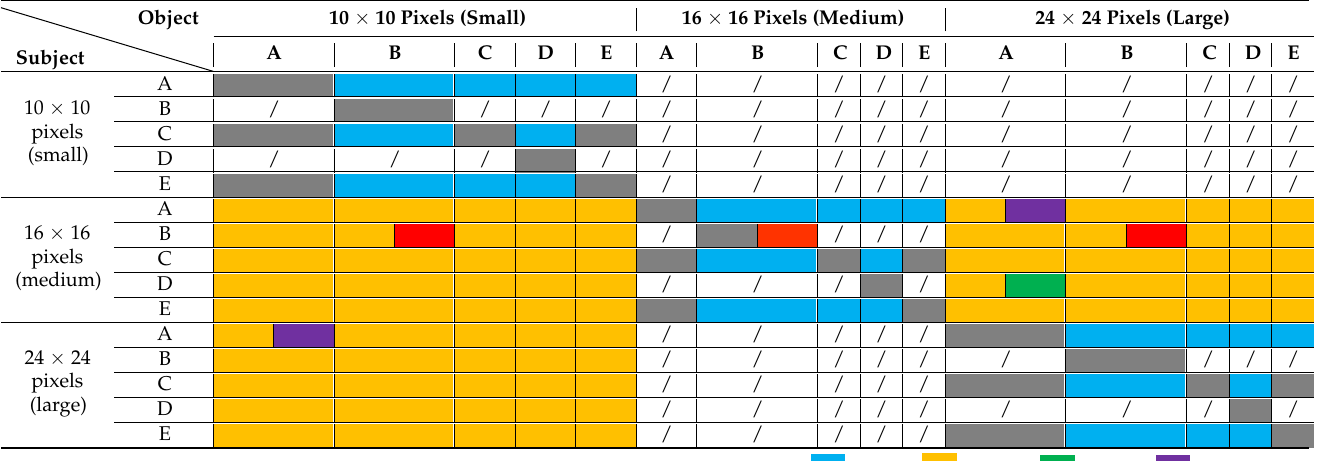
A: crossroad, B: curve, C: corner, D: T-junction, E: Y-junction. /: Non-processed Rule I: Rule II: Rule III: Rule IV: